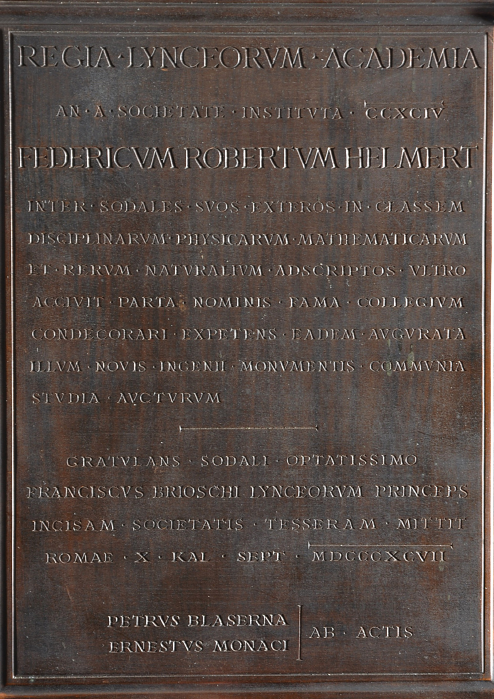
Figure 5. Commemorative plaque: “The Royal Academy of Sci- ences, in the 294th year after its founding, has accepted Friedrich Robert Helmert as a corresponding member of the Physics– Mathematics–Natural Sciences Class in acknowledgement of the renown he has gained through his endeavours to embellish this body and in the expectation that he will enrich common research efforts through new demonstrations of his talents. It is with cordial congrat- ulations to our warmly welcomed colleague that the director of the academy, Francesco Brioschi, presents this inscribed plaque. Rome, 23 August